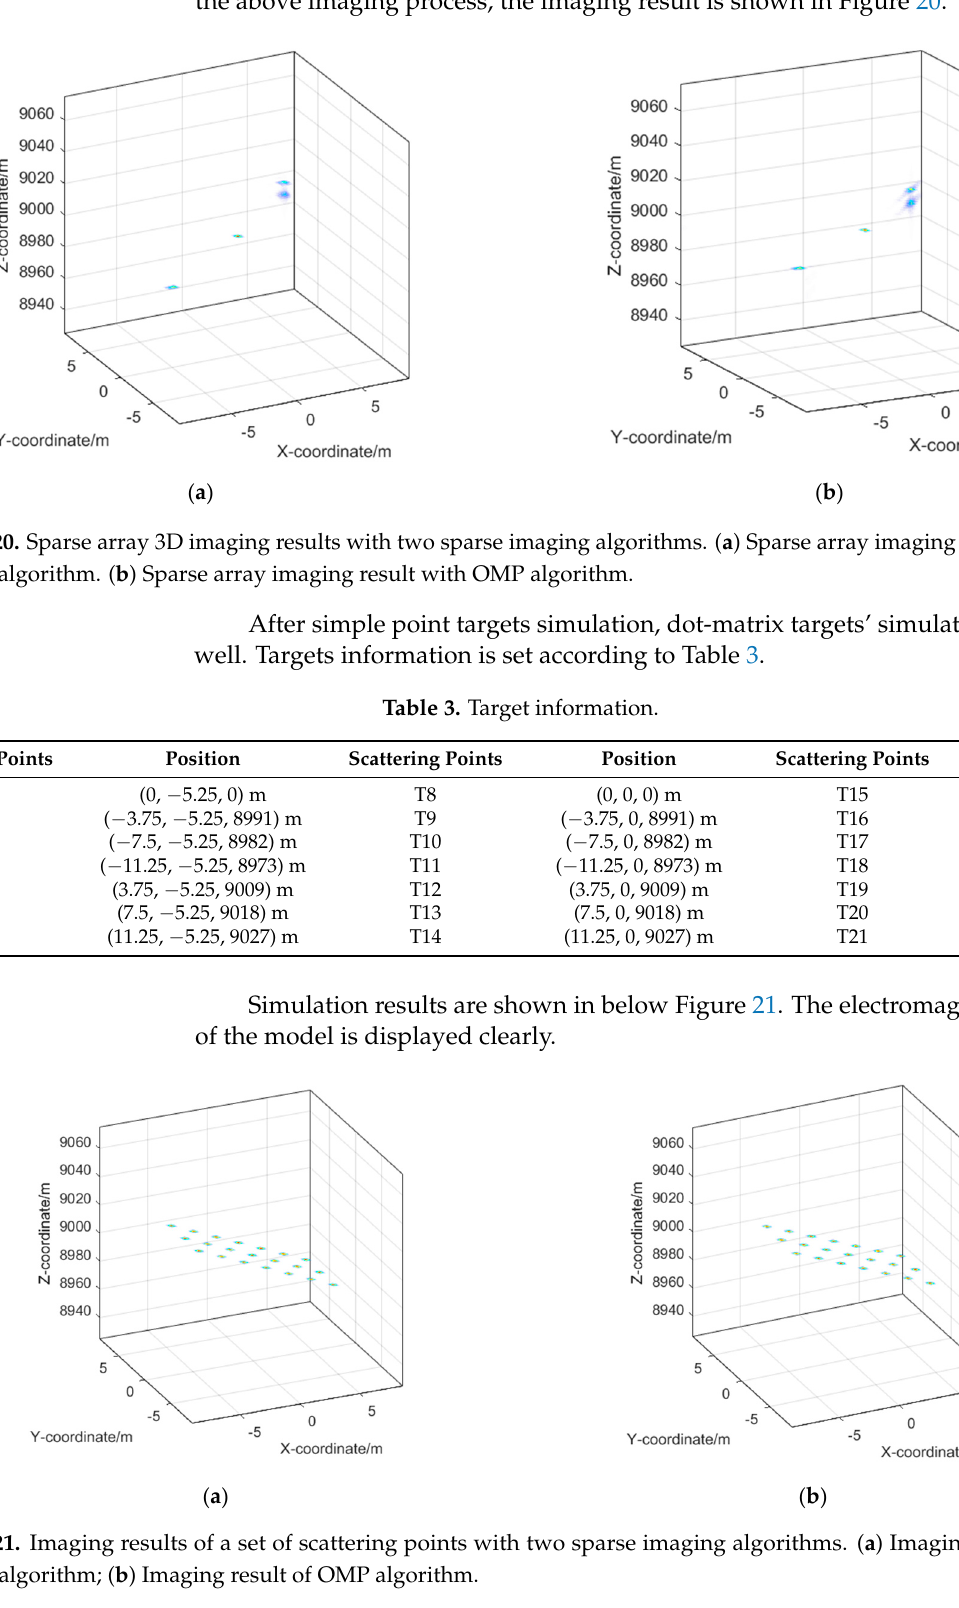
Figure 8. Separation result of sparse array range profile. ( a ) The range profile of target 1 of sparse